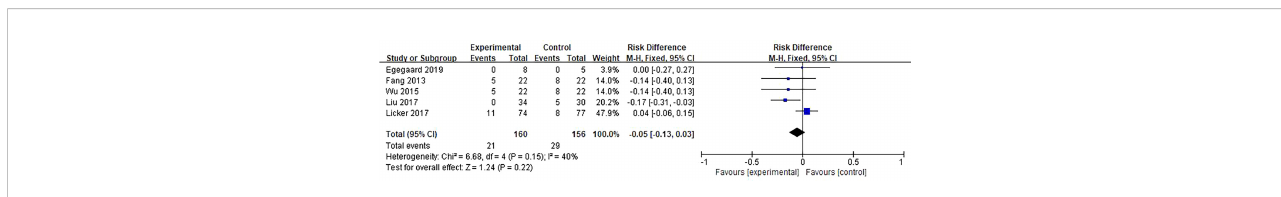
FIGURE 6 Meta-analysis of the effect of HIIT on arrhythmias among lung cancer